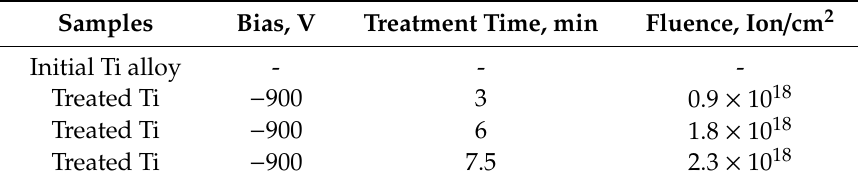
Table 1. Parameters of treatment of the titanium alloy by copper